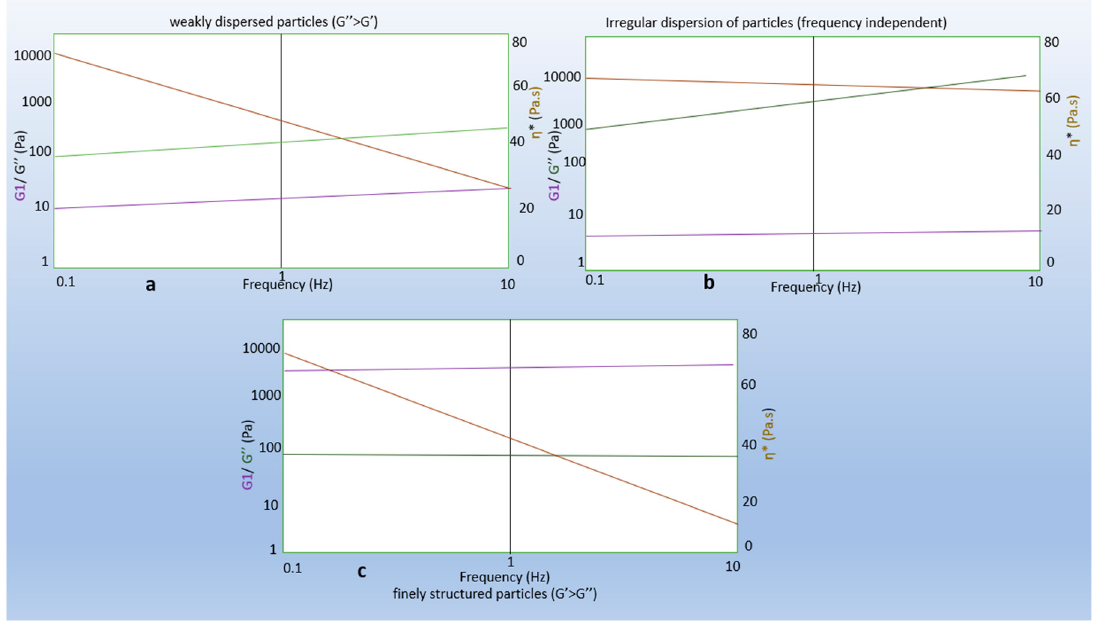
Figure 2. Graphs representing viscoelastic parameters: ( a ) weakly dispersed particles (G’’ > G’); ( b ) irregular dispersion of particles; ( c ) fine structured particles (G ′ > G ″ ) [49]. Lines legend: purple for G ′ , elastic modulus; green for G ″ , viscous modulus; and orange for η *, complex viscosity...